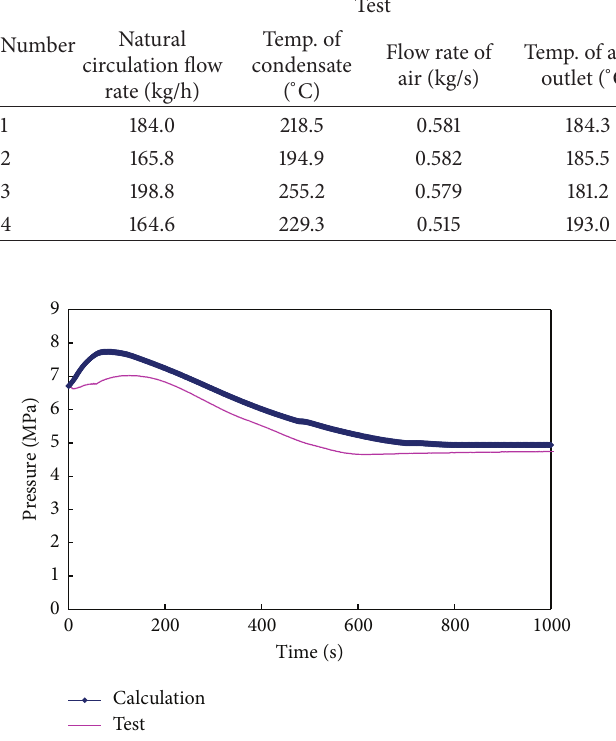
Figure 11: The pressure comparison between calculation and test.